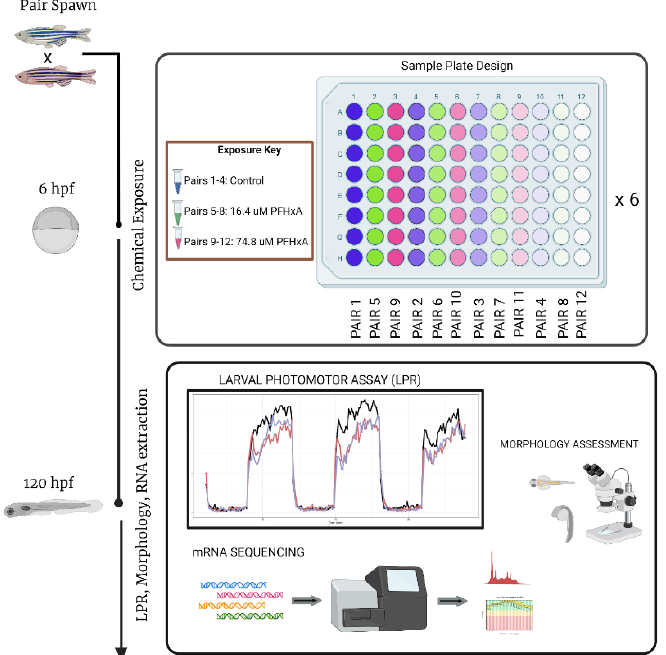
Figure 1. Experimental setup for direct embryonic exposure study (zebrafish embryos exposed to control, 16.4 µ M or 74.8 µ M of PFHxA from @ 6hpf; phenotypic measurements, i.e., behavioral assessments at 120hpf; developmental assessments of 13 specific morphology endpoints at 120 hpf)